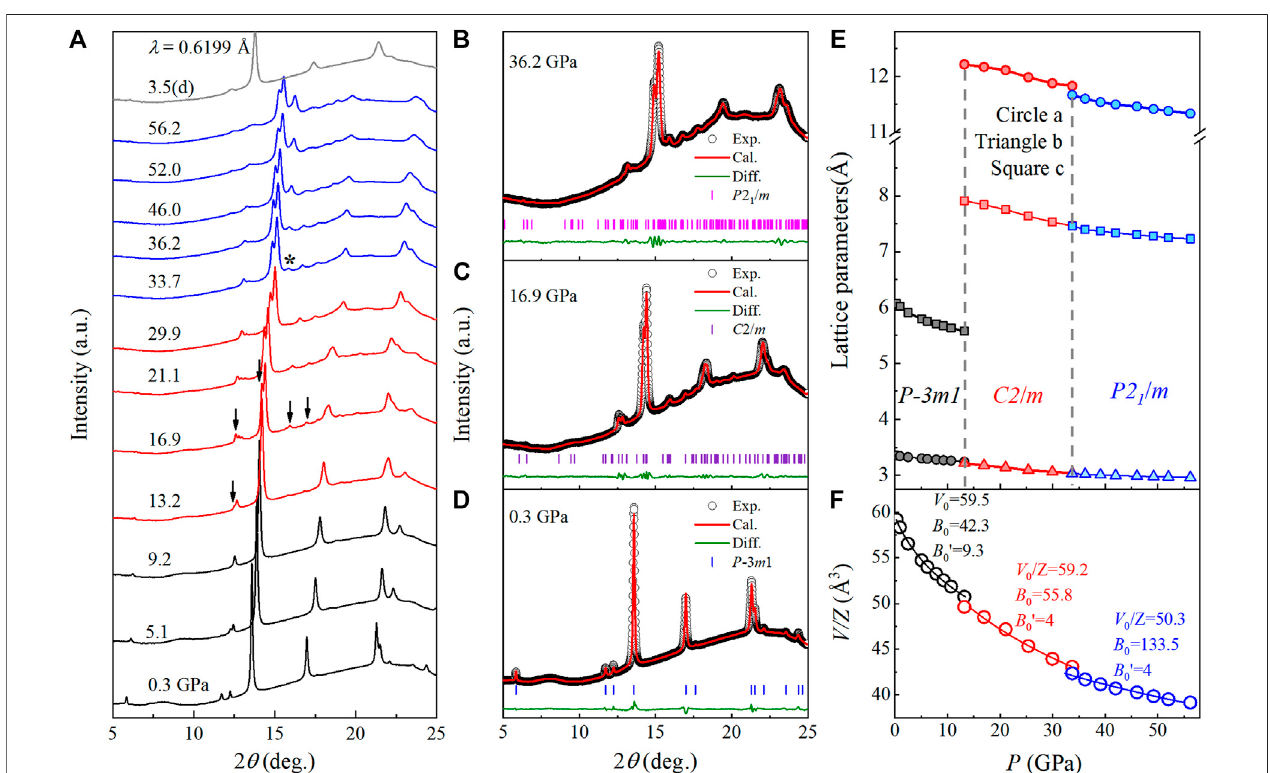
FIGURE 4 | (A) High-pressure XRD patterns for powdered 1 T -VSe 2 single crystals under pressures from 0.3 to 56.2 GPa, and then down to 3.5 GPa ( “ d ” means decompression). The diffraction wavelength λ (cid:2) 0.6199 Å. (B) – (D) Representative fi ttings of the XRD patterns at 36.2, 16.9, and 0.3 GPa. (E) Pressure dependence of the lattice parameters a , b, and c . (F) Pressure dependence of the lattice volume of a unit